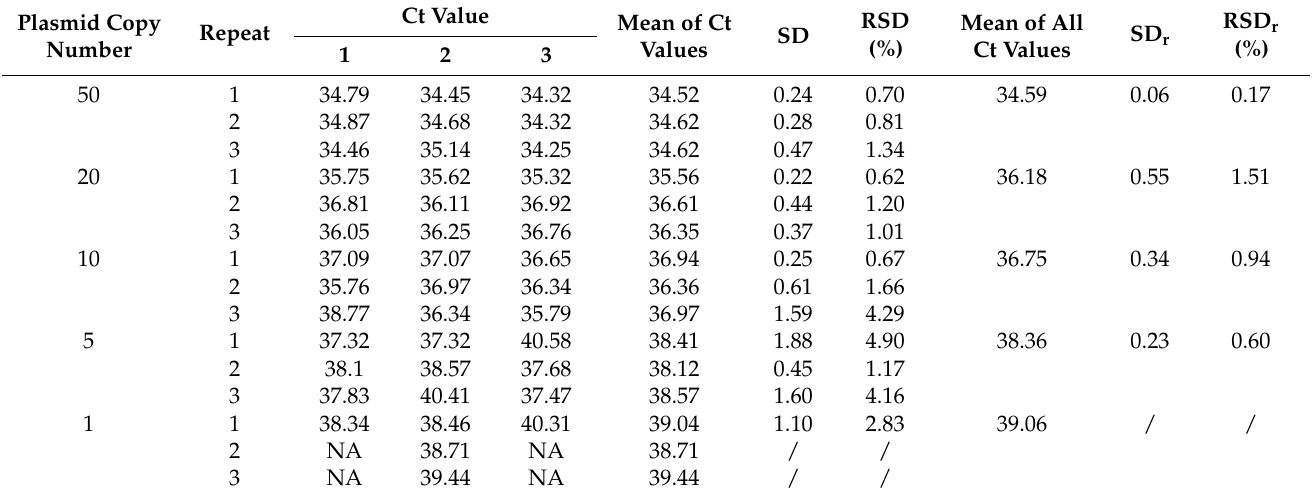
Table 4. Estimation of LOD and LOQ of qPCR using serially diluted plasmid